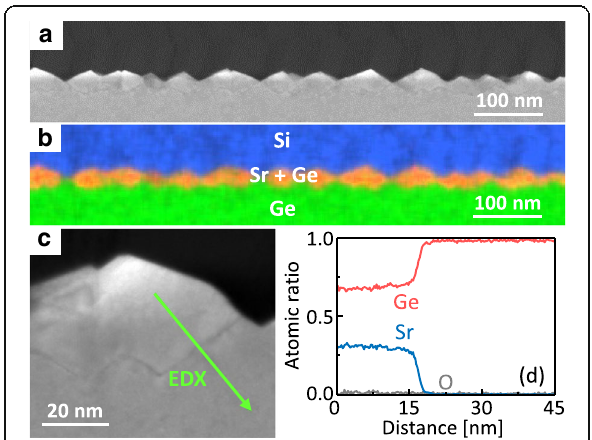
Fig. 3 HAADF-STEM and EDX characterization of the SrGe 2 thin film grown on the Ge (110) substrate at 500 °C. a HAADF-STEM image. b EDX elemental map from the region shown in panel a . c Magnified HAADF-STEM image. d Elemental composition profile obtained by a STEM-EDX line scan measurement along the arrow in panel ( c